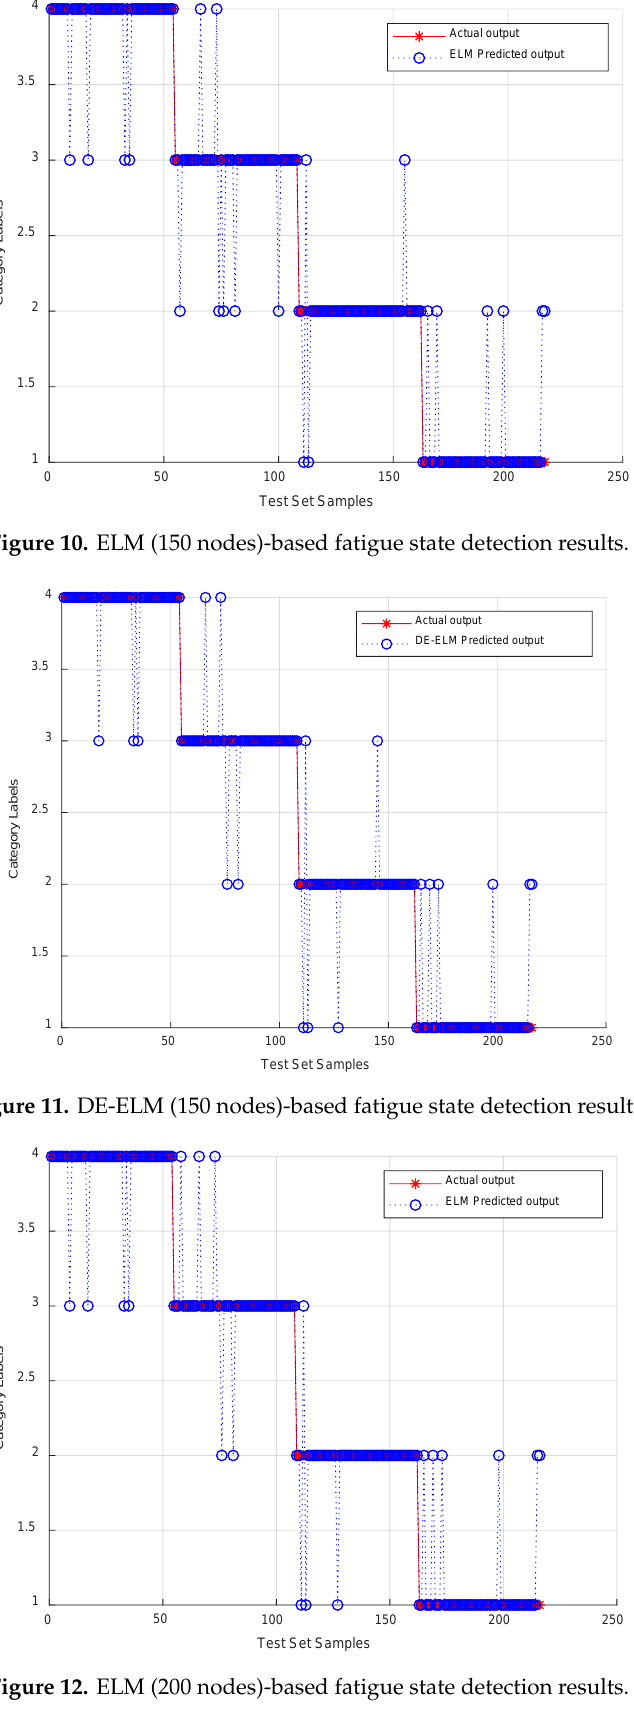
Figure 13. DE-ELM (200 nodes)-based fatigue state detection results.